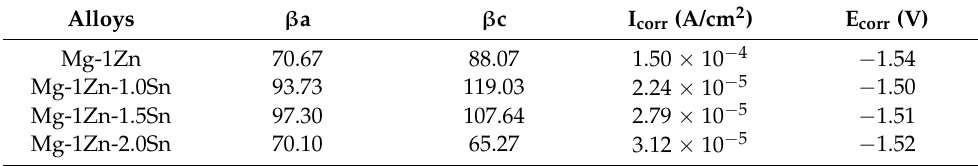
Table 4. Parameters of the alloys fitted from potentiodynamic polarization